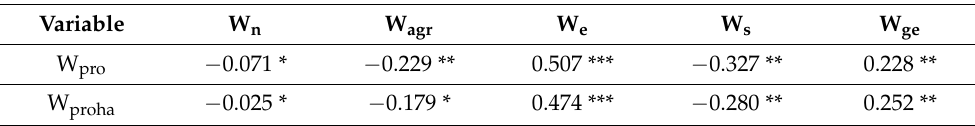
Relationship between the implementation of green economy principles and agri- environmental-climate